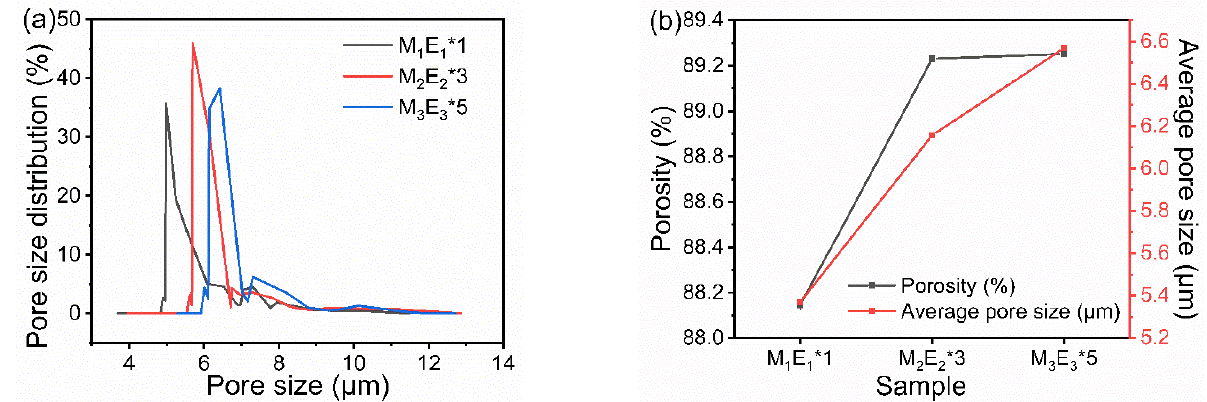
Figure 6. Composite filter ( a ) Pore size distribution and ( b ) porosity and average pore size.